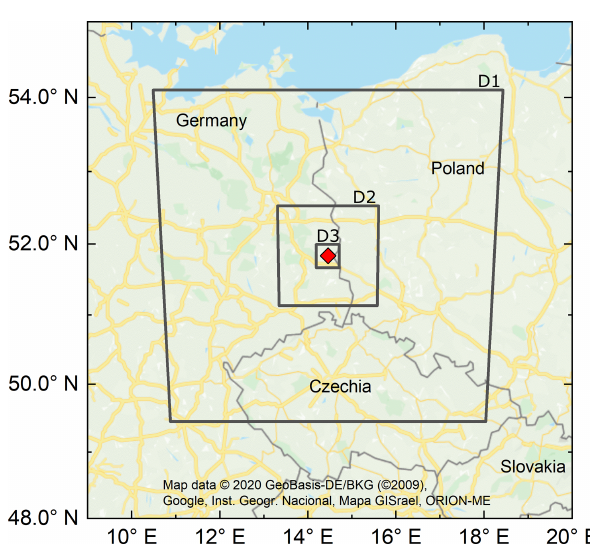
Figure 5. Location of three time-nested domains (black squares) of the WRF simulation. They are centered on the power plant Jän- schwalde (red square). The domains have a side length of 500 (D1), 150 (D2), and 35km (D3) and a horizontal resolution of 5 (D1), 1 (D2), and 0.2km (D3). Vertically, 57 eta levels are introduced, ranking from the ground up to a top layer pressure of